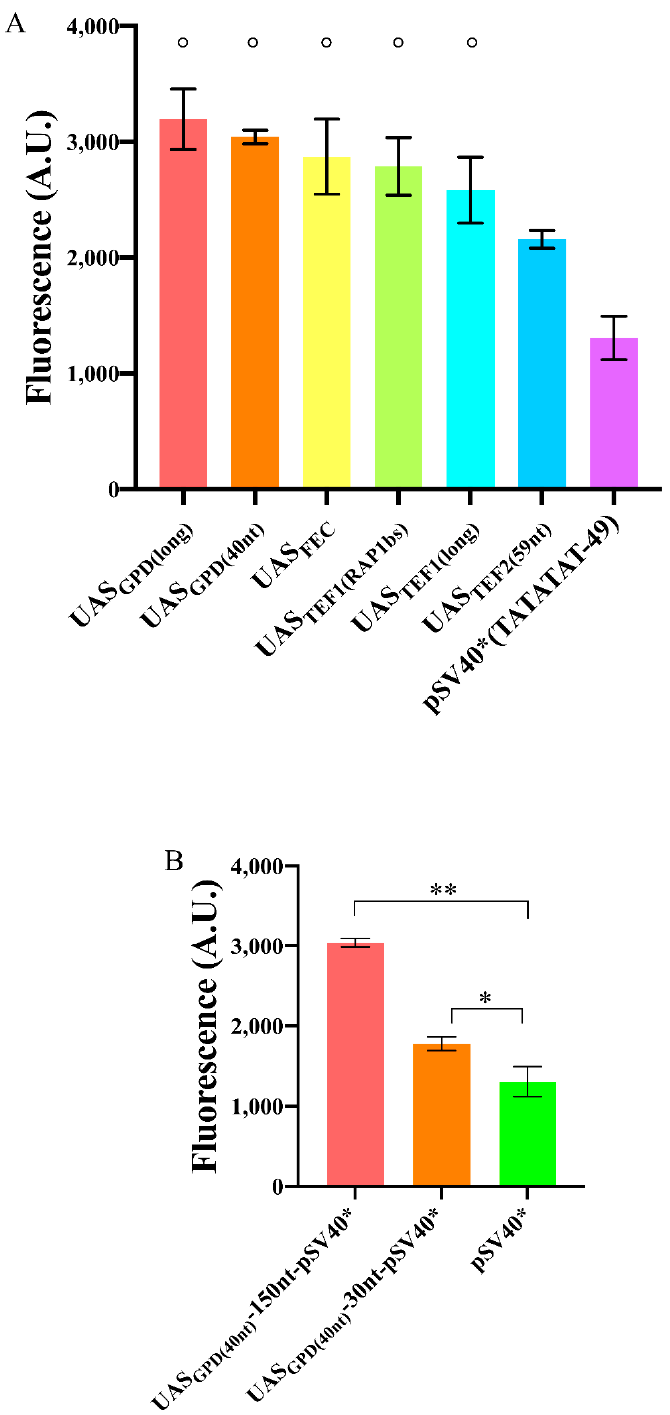
Figure 5. Enhancement in the fluorescence level of pSV40*(TATATAT-49) due to the presence of an UAS. ( A ) Most of the UASs considered in this work had a similar effect when placed 150 nt upstream of pSV40*(TATATAT-49). The symbol ◦ on top of five columns indicates no significant statistical difference ( p -value = 0.1005, one-way ANOVA) among the corresponding fluorescence levels. ( B ) Variation in fluorescence expression due to different spacers between UAS GPD(40nt) and pSV40*(TATATAT-49). The configuration with a 150 nt-long spacer was the most effective though 30 nt were enough to have a statistically significant increase in the fluorescence level of pSV40*(TATATAT- 49). Each mean fluorescence value is the result of three independent experiments; * corresponds to a p -value < 0.05; ** to a p -value < 0.01 (two-sided Welch’s t